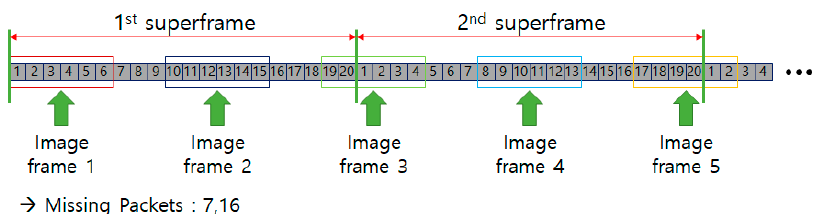
Figure 3. An example of receiving fragmented data using a rolling shutter-based optical camera communications (OCC) receiver.